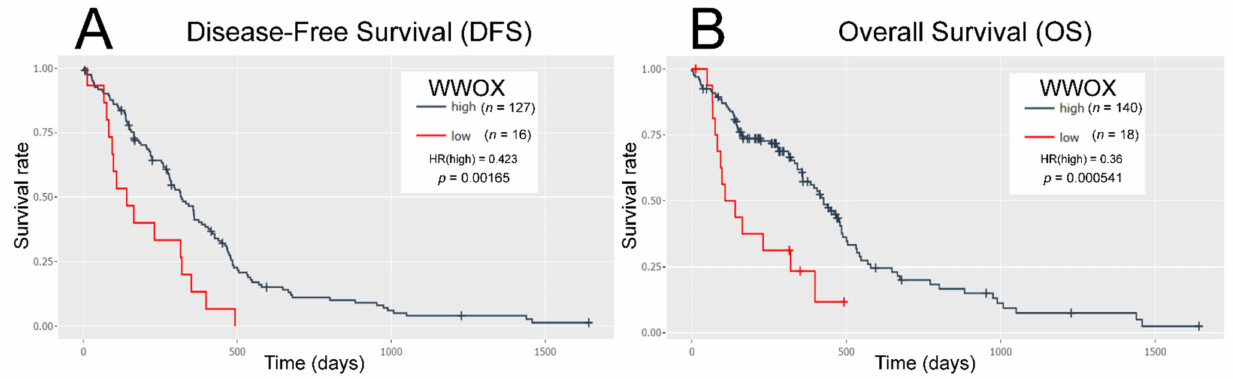
Figure 1. Survival analysis of low and high WWOX expression cut-off through Evaluate Cutpoints. ( A ) Disease-free survival (DFS). ( B ) Overall survival (OS).